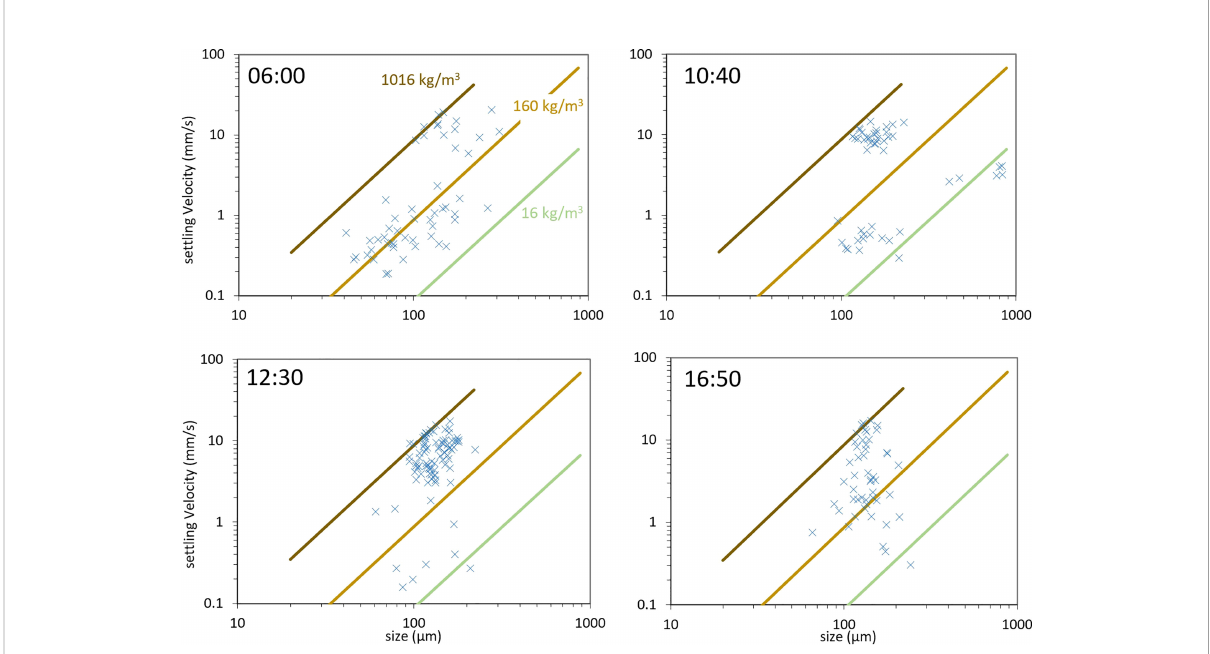
FIGURE 3 Settling velocities as function of equivalent diameter, as determined by LabSFLOC2 measurements at different GMT times of the survey